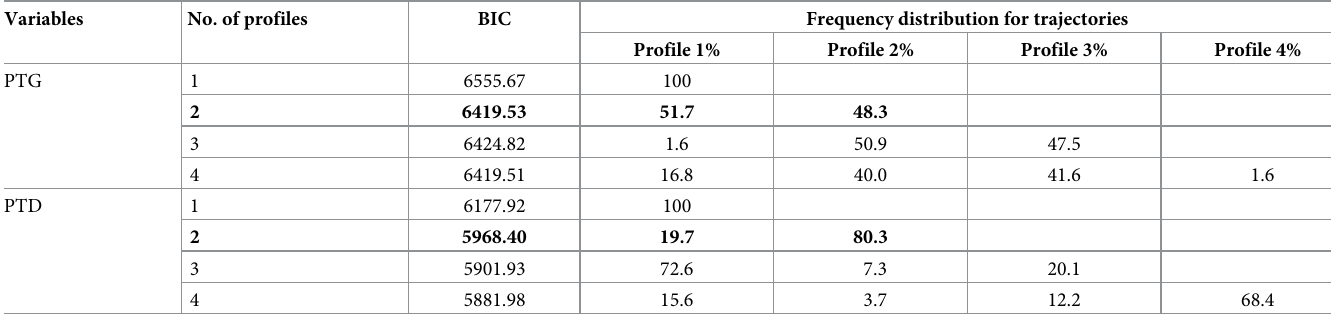
The relationships between the levels of resilience, gain and loss in the first measurement and detected trajectories were analyzed with the use of logistic regression analysis. Resilience and resource gain and loss were analyzed as predictors. The types of PTG and PTD trajectory (pro- file 1 or profile 2) were analyzed as explained variables. The results are presented in Table 5. The decreasing trajectories (profile 2) were coded as 1. Table 4. BIC index values and profiles distribution for analyzed models.